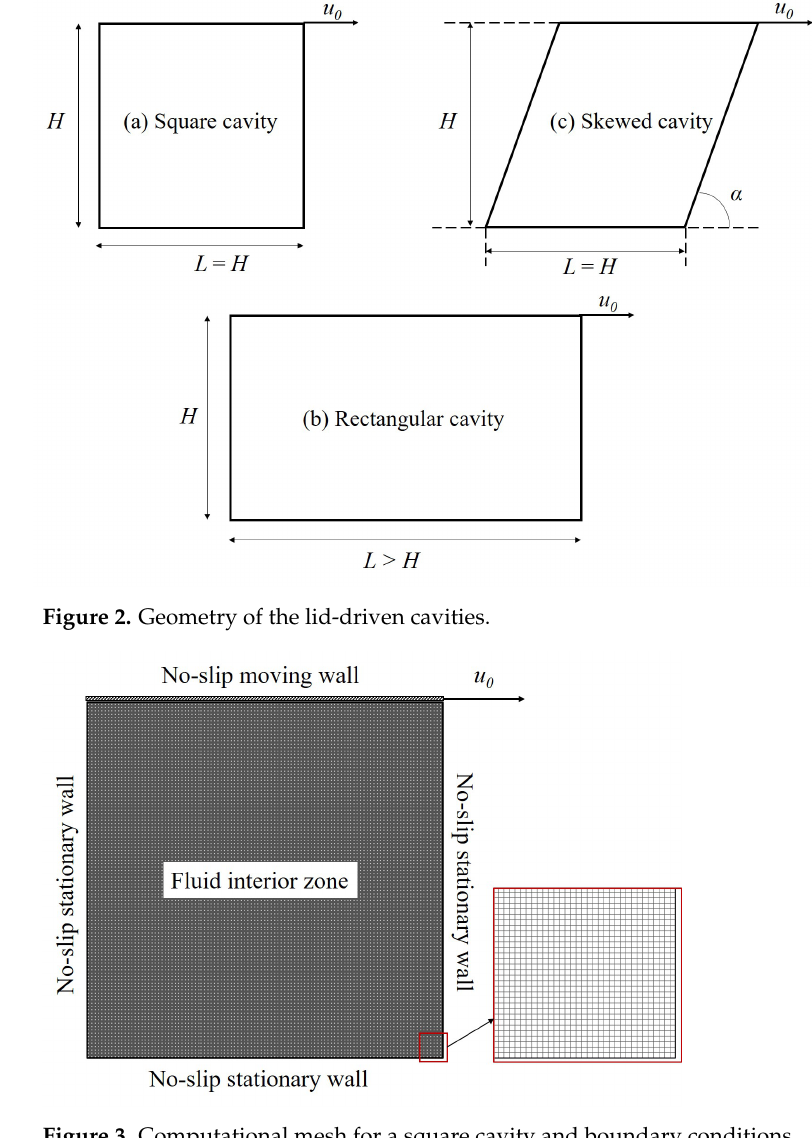
Figure 3. Computational mesh for a square cavity and boundary